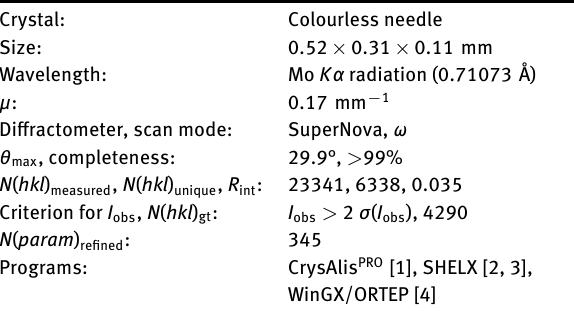
Table 1: Data collection and